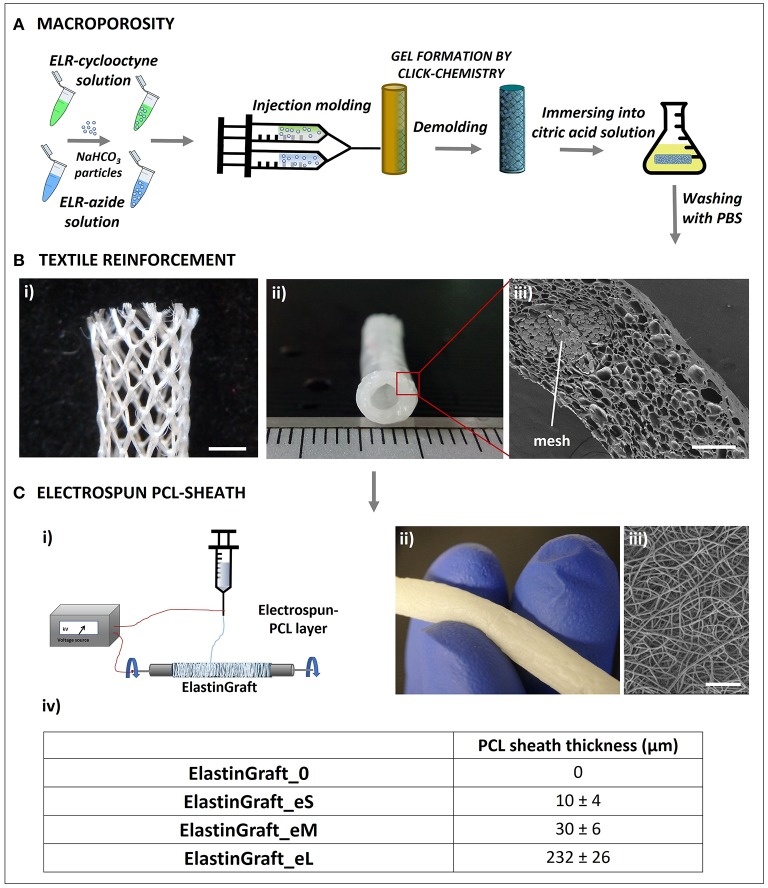
Biofabrication scheme of the ElastinGrafts: textile-reinforced macroporous vascular grafts based on ELRs. (A) Procedure used to obtain the macroporous click-ELR vascular graft. (B) Images of the textile-reinforced macroporous vascular graft: (i) PVDF-textile reinforcement to provide mechanical strength. (ii) Elastin graft. (iii) Cross-sectional SEM image of the macroporous ELR-vascular graft. (C) Electrospun PCL-sheath. (i) Sketch of the electrospinning procedure. (ii) Macroscopic image of the ElastinGraft enclosed with a PCL-sheath. (iii) SEM images of the electrospun sheath around the ELR-scaffold. (iv) Different versions of the ElastinGrafts differing in the thickness of the electrospun PCL-sheath. Specifically, “0” refers to “no e-spun layer”; “eS” to “the smallest thickness of the e-spun layer,” “eM” to “the intermediate thickness of the e-spun layer” and “eL” to “the largest thickness of the e-layer.” Scale bars: (B) (i) 2 mm; (iii) 200 μm; (C) (iii) 50 μm.